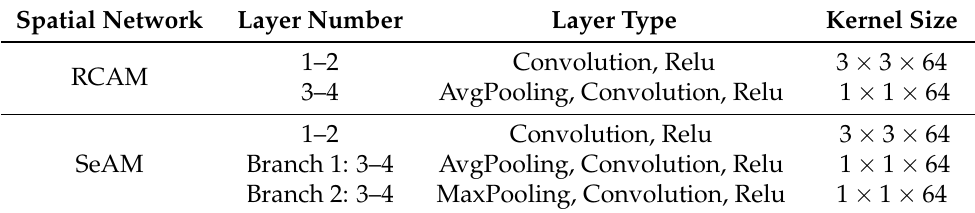
Table 1. The specific parameter settings of the spatial